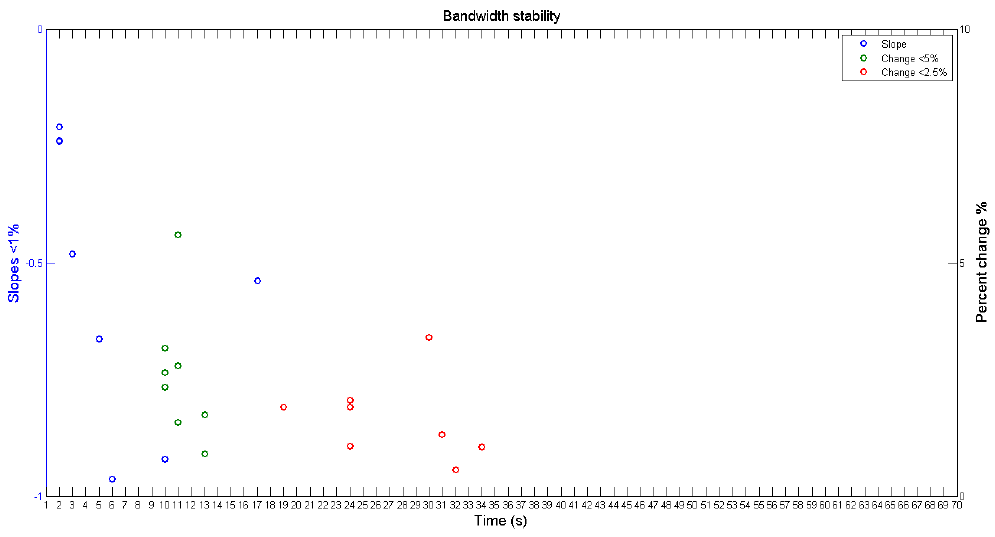
Figure 6. Times at which the different criteria stabilize.